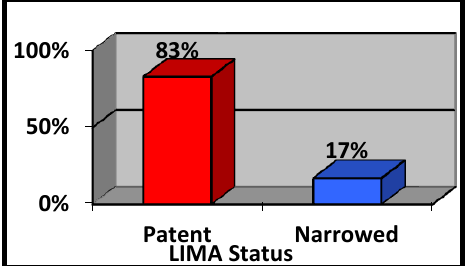
Fig. (6): T he Results for the CTCA on a "per-artery"